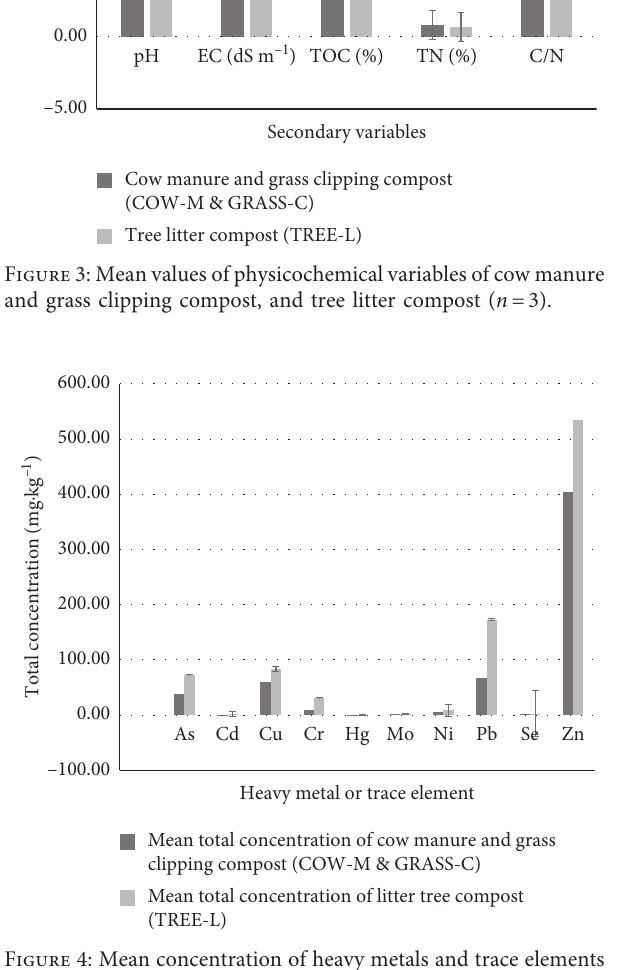
Figure 4: Mean concentration of heavy metals and trace elements of interest in cow manure compost and grass clipping vs tree litter compost ( n �